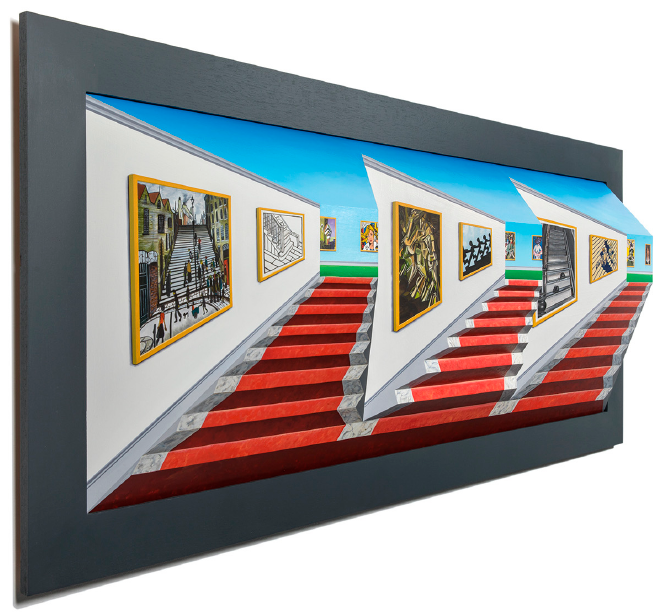
Figure 3. “Stairs to the Stars” (2016).